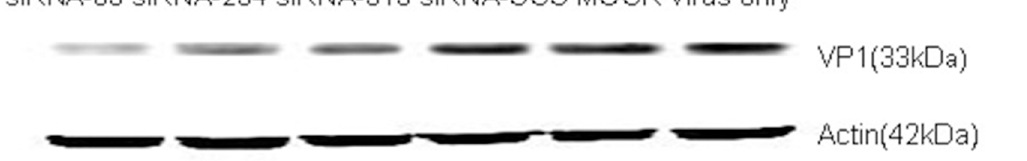
Fig 6. RNAi inhibits viral protein. RD cells transfected with siRNA were infected with strain EV71-2006-52-9 at an MOI of 0.01. At 36 h postinfection, total protein was extracted and analyzed with western blotting. β -Actin was used as the internal loading control. The protein measurements were made in three independent experiments.